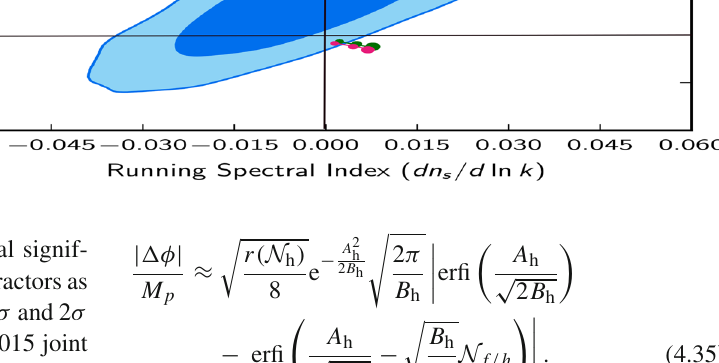
Fig. 6 Plot for running of the running of spectral index κ = d 2 n / d 2 ln k vs. running S S of the spectral index β = d n / d ln k for scalar S S modes. Here for Case I and Case II we have drawn green and pink colored lines . We also draw the background of the confidence contours